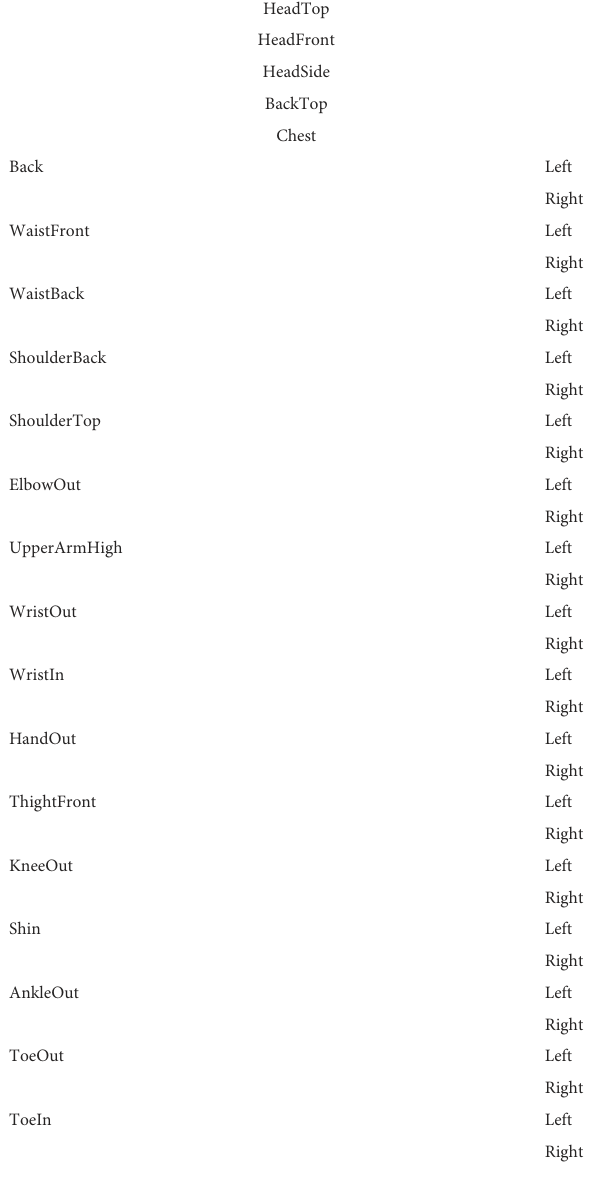
TABLE 1 List of OptiTrack baseline